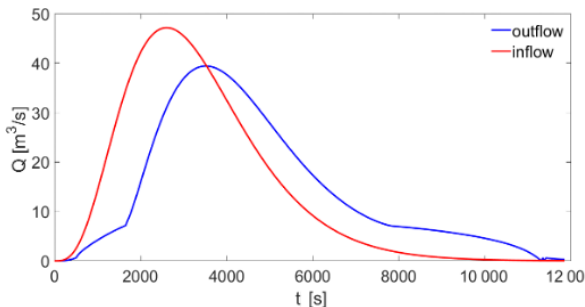
Figure 2. Example of flood mitigation induced by the presence of a detention basin obtained via numerical simulation. Other parame- ters are b = 1m; d = 1m; n = 1 . 9; h f = l f + d/ 2; h s = 4; µ f = 0 . 85; µ s = 0 . 385; L = 3m, W max = 15000m 3